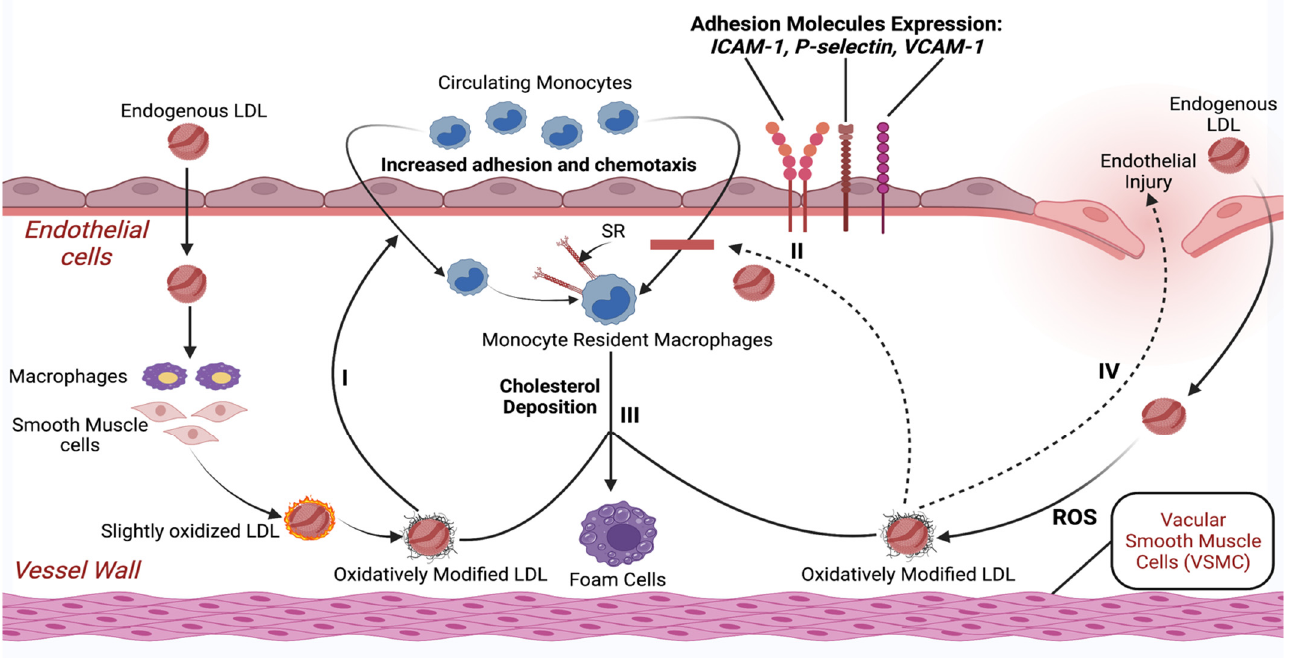
Figure 1. Schematic illustration of endothelial damage and initiation of the atherosclerotic process with only higher LDL levels as a risk factor. Abbreviations: LDL—low-density lipoprotein; ROS— reactive oxygen species; SR—scavenger receptor; ICAM-1—intercellular adhesion molecule-1; VCAM-1—vascular cell adhesion protein-1. Created with BioRender.com (accessed on 17 April 2021).